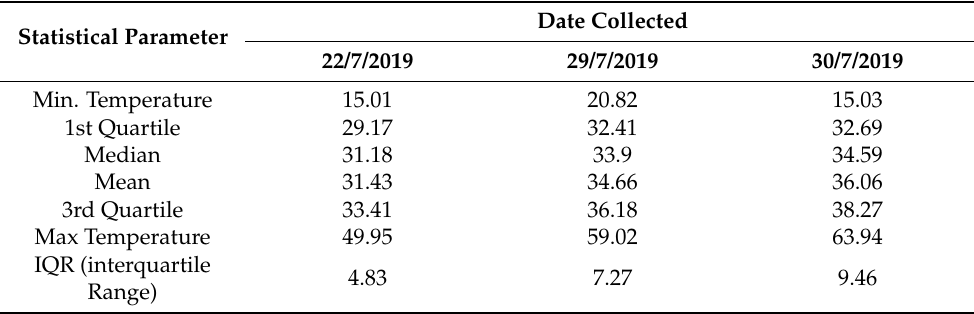
Table 3. Summary statistics of temperature values from the radiometric thermal imageries collected at different days.